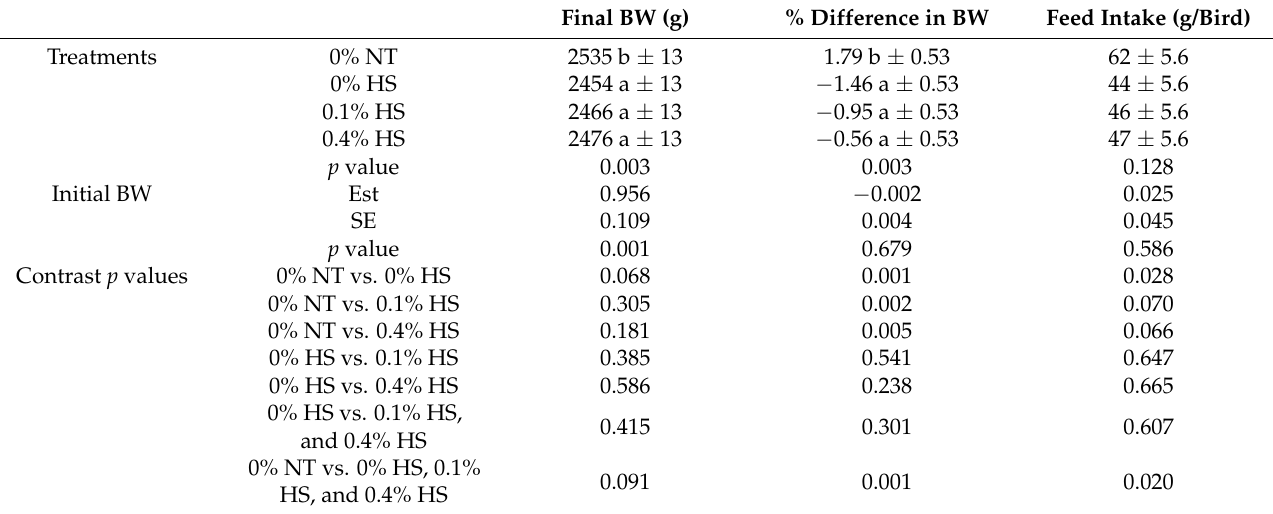
Table 1. Effects of supplementing diets with solubles from shredded, steam-exploded pine parti- cles (SSPPs) on the growth performances in broiler chickens exposed to either thermoneutral or heat-stress conditions. Final BW (g) % Difference in BW Feed Intake